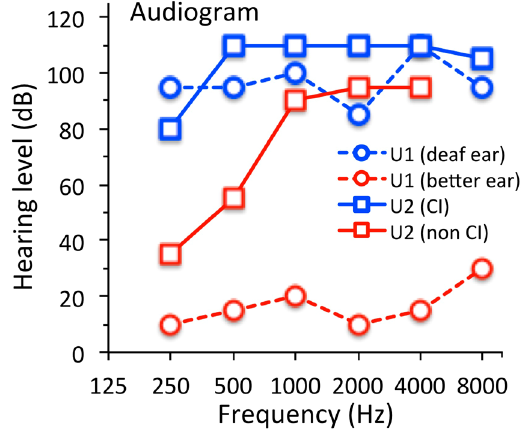
Figure 5. Audiogram for the two unilaterally deafened subjects. One subject, U1, was deaf in one ear (blue circles) and normal hearing ( ≤ 20 dB HL), except for mild hearing loss (30 dB) at 8,000 Hz, in the better ear (red circles). The other subject, U2, received a cochlear implant in the deaf ear (blue squares) and had residual low- frequency hearing in the non-implant ear (red squares).